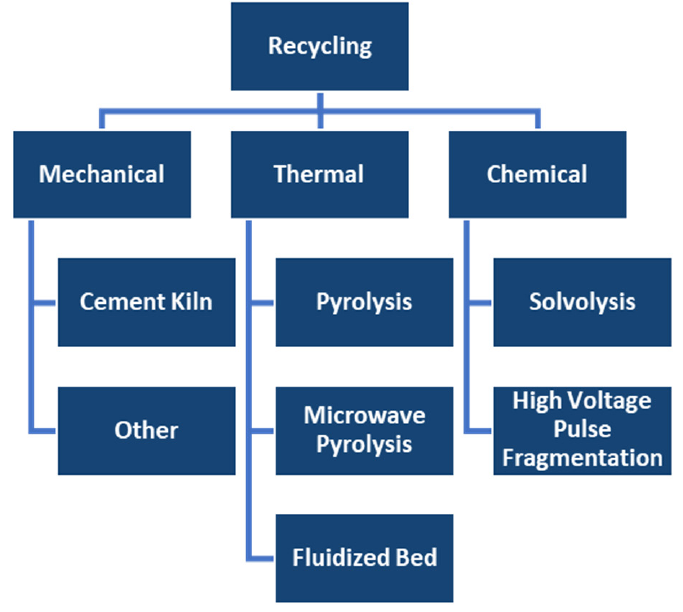
Figure 2. Possible recycling methods for EoL WTB waste.